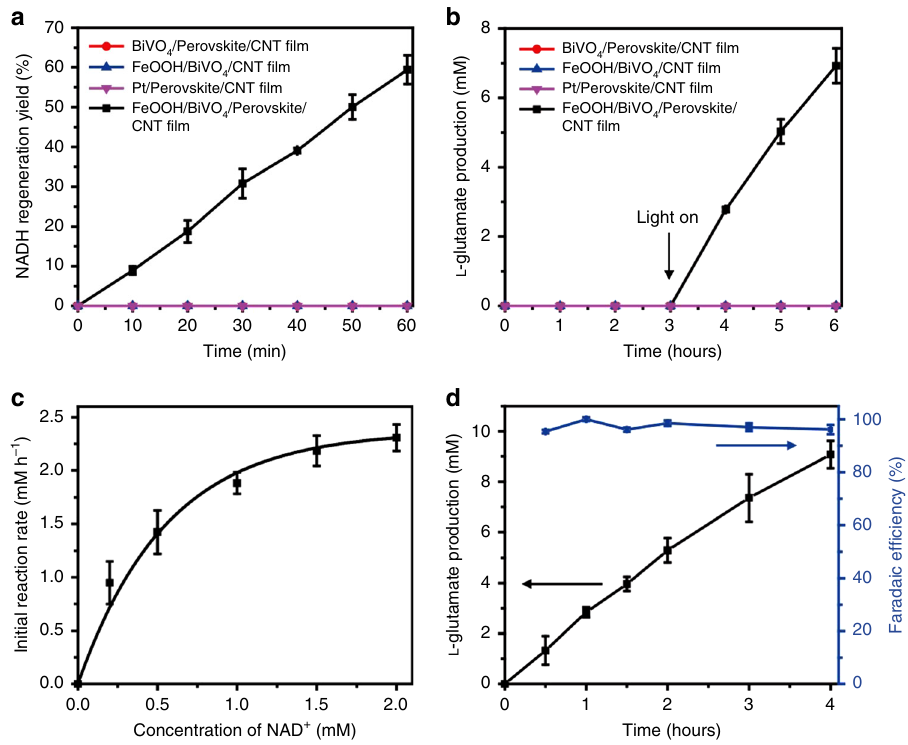
Fig. 5 Bias-free photoelectrochemical NADH regeneration and biocatalytic reactions. a Regeneration yield of NADH in the absence of the perovskite solar cell and FeOOH/BiVO 4 photoanode, and in the tandem con fi guration with both photoanode and photovoltaic module under illumination. b Biocatalytic production of L -glutamate in the absence of the perovskite solar cell and FeOOH/BiVO 4 photoanode, and in the tandem con fi guration with both photoanode and photovoltaic module under illumination. c In fl uence of NAD + concentration on the initial reaction rate of PEC biocatalytic production of L - glutamate under illumination. d Time pro fi le of biocatalytic production of L -glutamate (black) in the tandem con fi guration with NAD + (2 mM) and the estimated faradaic ef fi ciency (blue) of the PEC biocatalytic production of L -glutamate from the total charge fl owed through the tandem system (mean ± standard deviation, n =